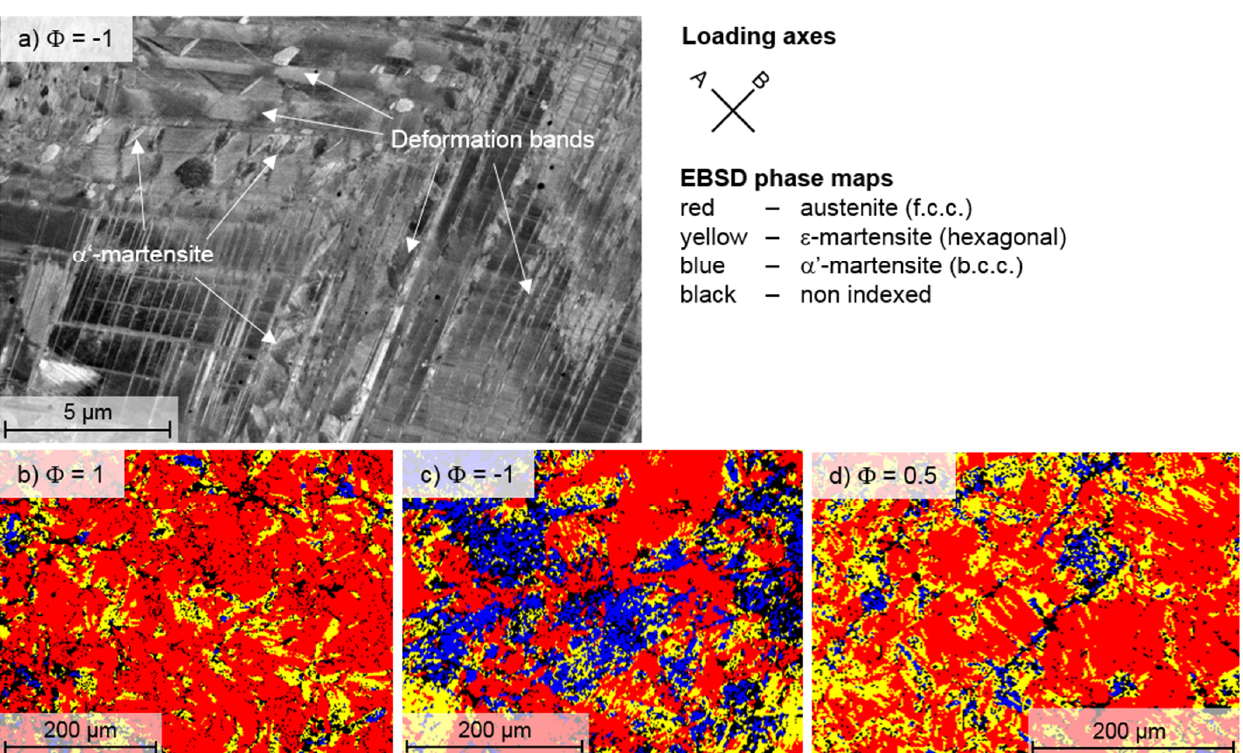
Figure 4: TRIP steel PM 16-7-6: a) SEM micrograph (backscattered electron contrast) showing deformation bands and  ’-martensite after cycling with  = -1 (shear loading) at Δ  vM /2 = 0.4 · 10 -2 . EBSD phase maps after cycling with b)  = 1 (equibiaxial loading), c)  = -1 and d)  = 0.5 at Δ  vM /2 = 0.4 · 10 -2 :